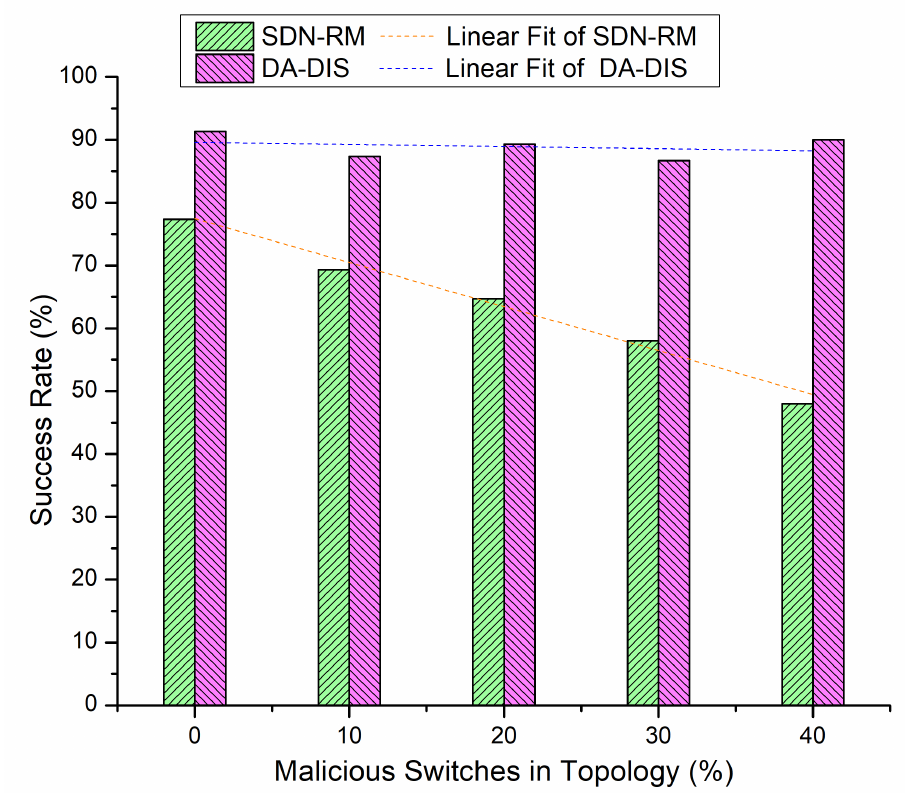
Figure 13. Success rate considering different numbers of malicious switches with E2 category